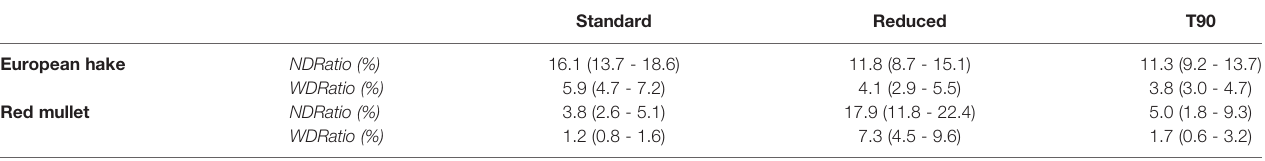
Values in brackets represent the lower and upper 95% CIs.